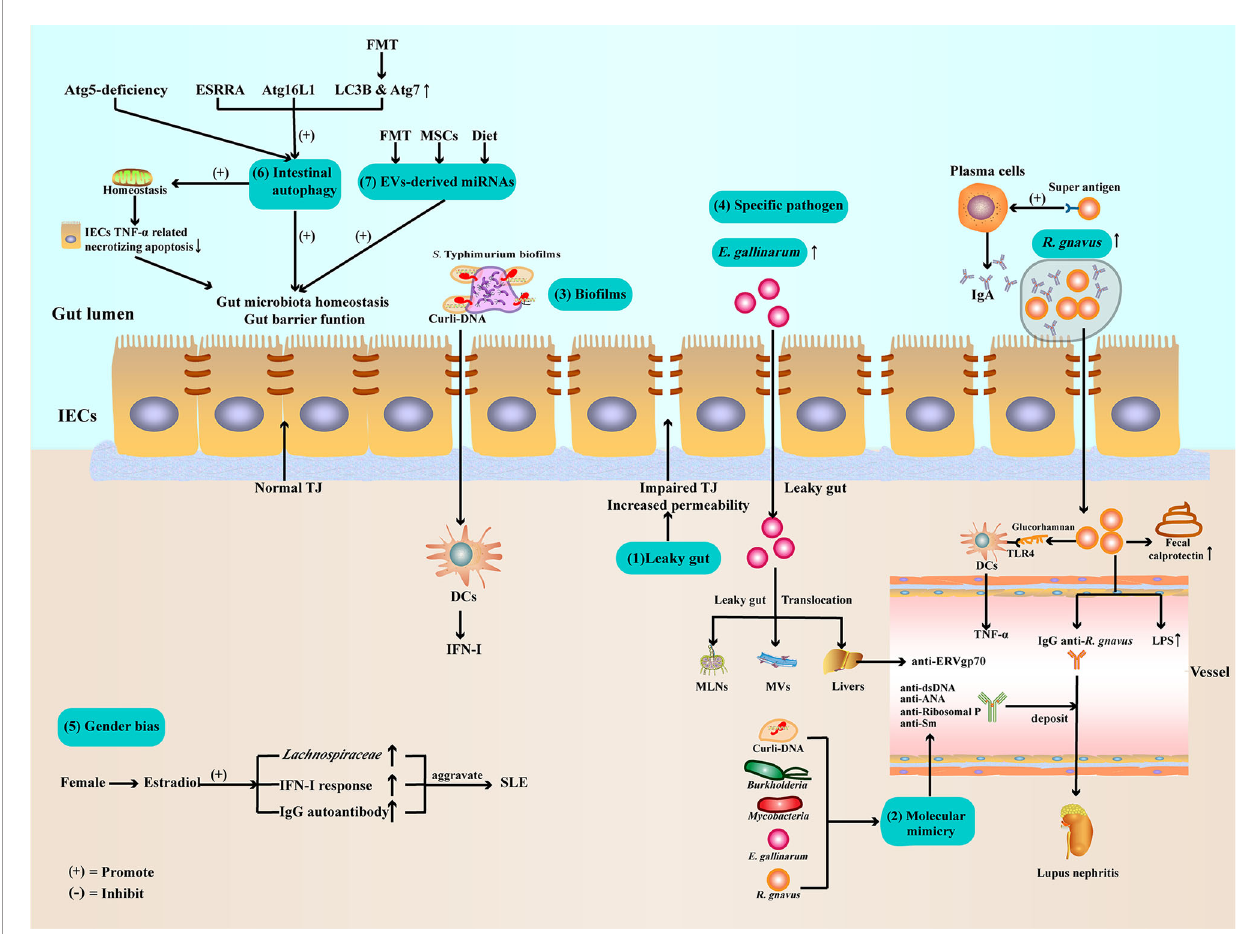
lupus nephritis (3). Curli-DNA of bio fi lms activated DCs to secrete pathogenic IFN-I (4). E. gallinarum can disrupt intestinal barrier function and translocate to MLNs, MVs, and livers. At the same time, E. gallinarum promoted systemic autoimmunity by inducing ERV gp70 overexpression in the liver. R. gnavus express a